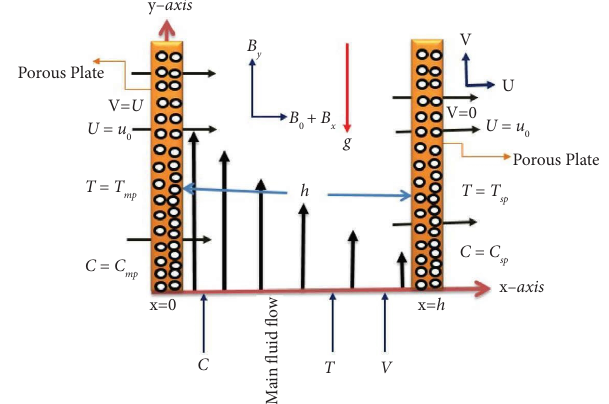
Figure 1: Schematic diagram of the physical